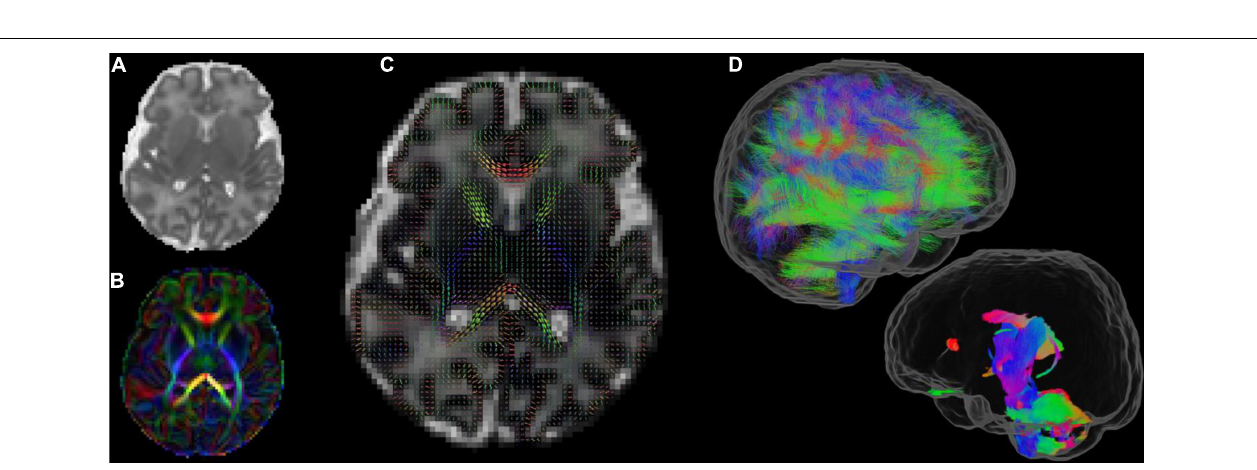
FIGURE 7 | Diffusion MRI (dMRI) data from the same infant. Shown are four selected volumes with different b -values and phase encoding directions. Left: input data after MB-SENSE reconstruction. Middle: images after denoising. Right: images after motion and distortion correction and destriping.